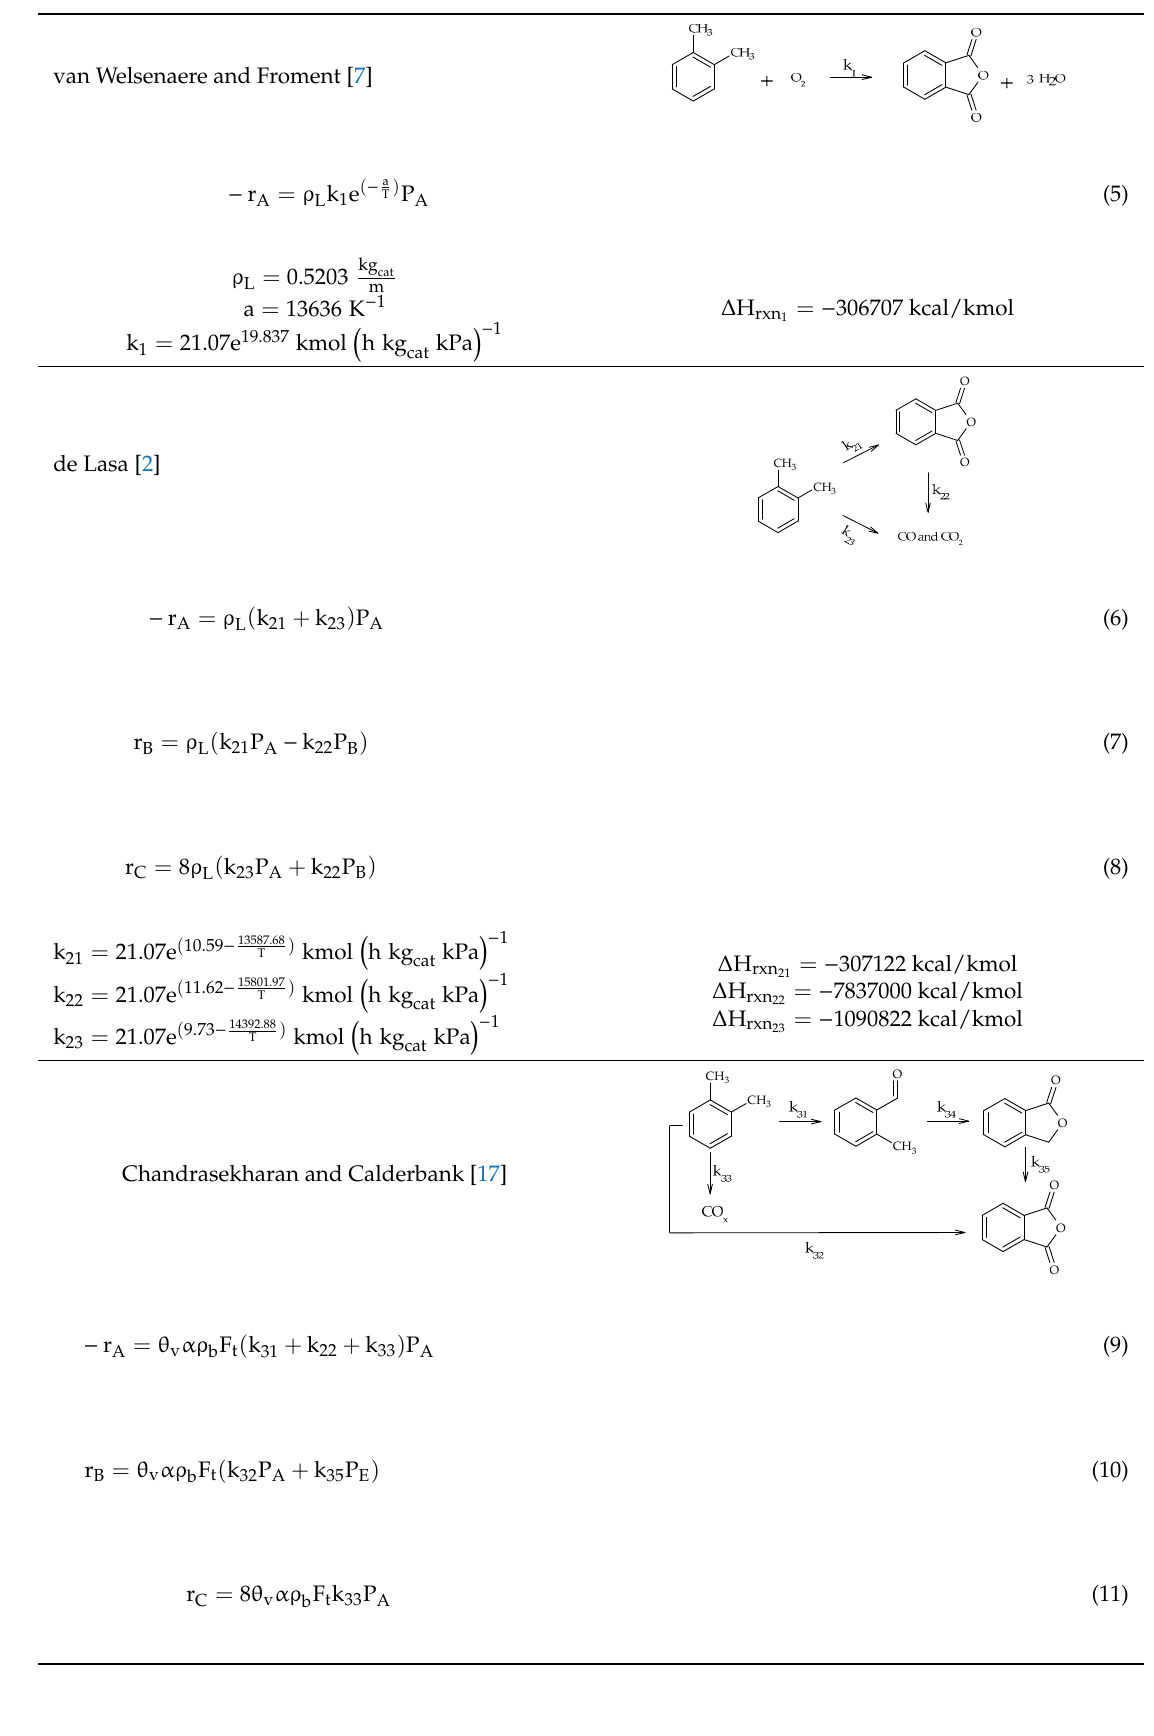
Table 3. Kinetic models for o-xylene oxidation considered in this work.